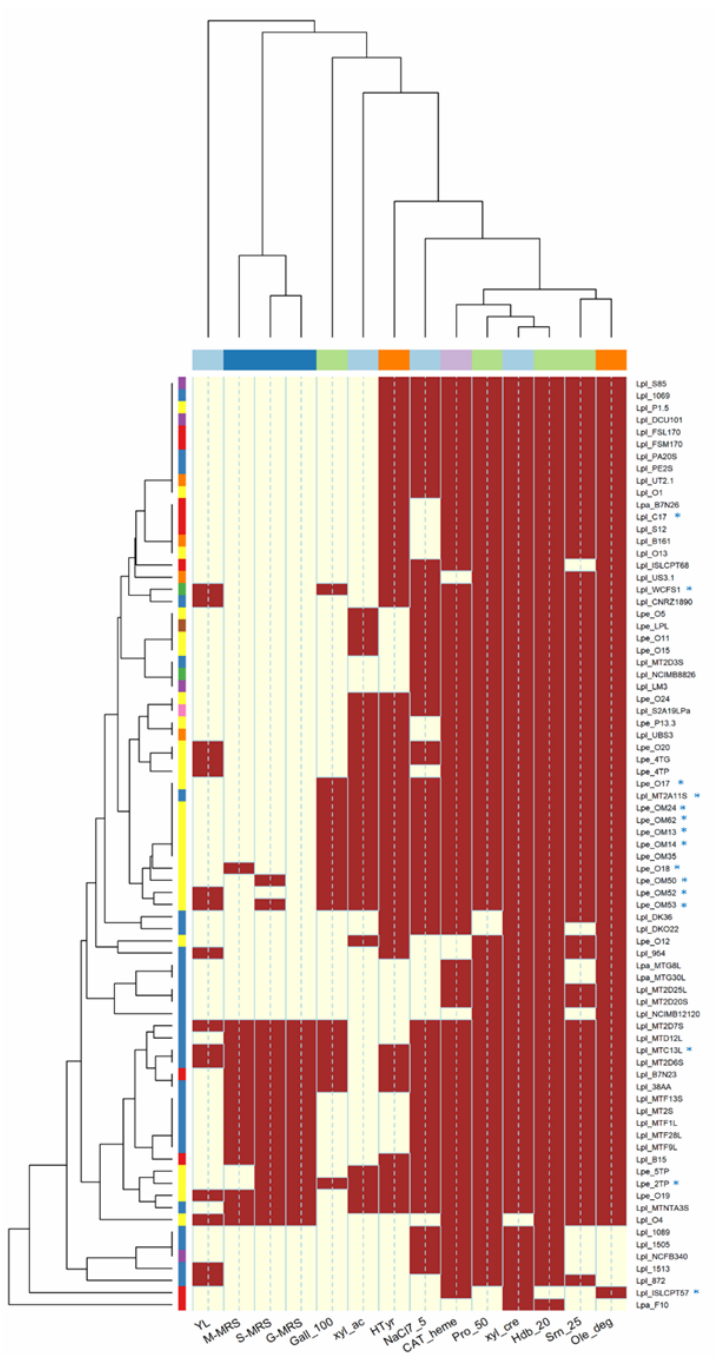
Figure 1. Correlation among technological properties of Lactiplantibacillus strains. Red box: positive; yellow box: negative. Code of columns of the dendrogram: YL, antimicrobial activity against Yarrowia lipolytica ; M-MRS, S-MRS and G-MRS, production of exopolysaccharides on maltose, sucrose and glucose, respectively; Gall_100 (100 mM gallic acid), Pro_50 (50 mM protocatechuic acid), Hdb_20 (20 mM 4-hydroxybenzoic acid) and Srn_25 (25 mM syringic acid) referred to phenolic compound tolerance; xyl_cre, growth on xylose; xyl_ac, acid production from xylose; NaCl7_5, salt tolerance; CAT_heme, catalase activity; Ole_deg, oleuropein hydrolysis; Htyr, hydroxytyrosol formation. Rows of the dendrogram (similarity relationships among strains): LAB species: Lpl, Lpb. plantarum , Lpa, Lpb. paraplantarum , Lpe, Lpb. pentosus ; isolation source: vegetables (violet), sourdoughs (blue), olives and derived products (yellow), dairy products (red), wine (orange), human sources (green), meat products (brown), unknown sources